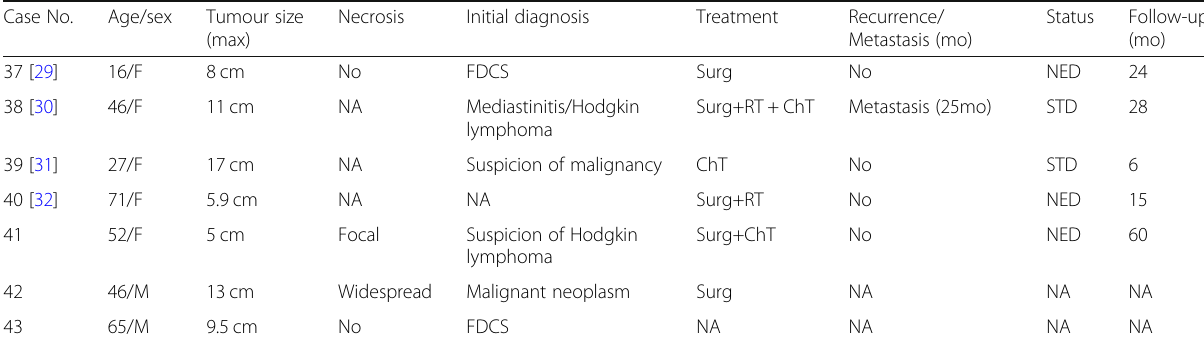
Table 2 Summaries of 43 cases of mediastinal follicular dendritic cell sarcomas (Continued) Case No.